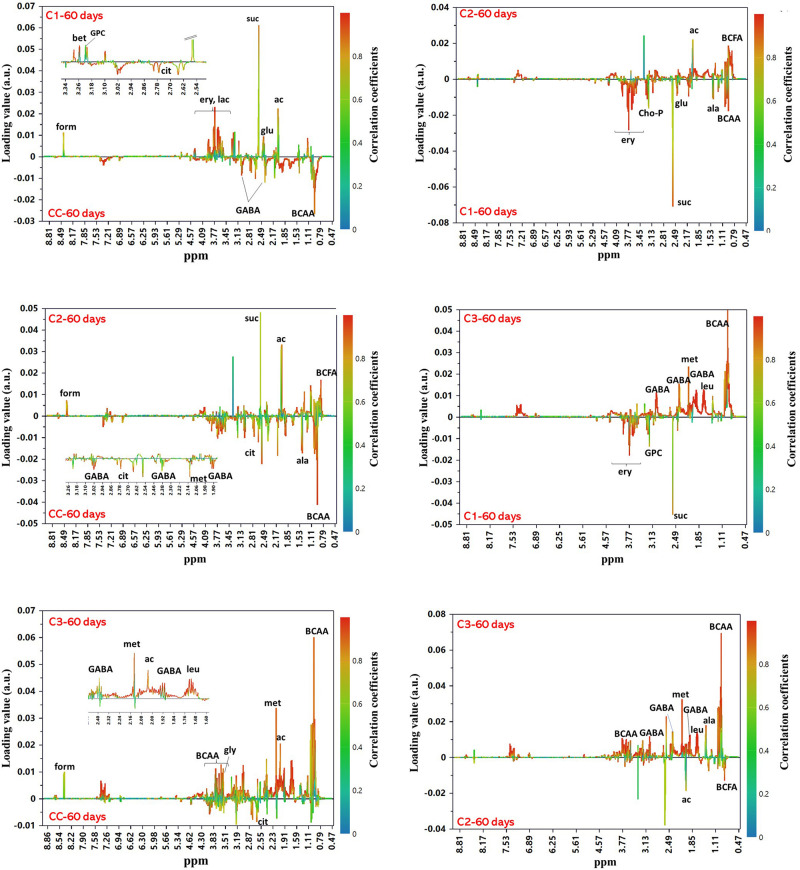
OPLS-DA S-line correlation coefficient plots for the pairwise comparisons between groups of cheeses at 60 days of ripening. For all models Q2Y > 0.95 and CV-ANOVA p-value < 0.0001. Only the signals from the major contributing metabolites toward the class separation are labeled (cutoff values: p(cov) ≥|0.05| and p(cor) ≥|0.5|). Abbreviations: ac, acetic acid; ala, alanine; BCAA, branched-chain amino acids; BCFA, branched-chain fatty acids; cho-P, phospho-choline; cit, citric acid; ery, erythritol; form, formic acid; GABA, γ-aminobutyric acid; gly, glycine; glu, glutamate; GPC, glycero-phosphocholine; lac, lactose; leu, leucine; met, methionine; suc, succinic acid.